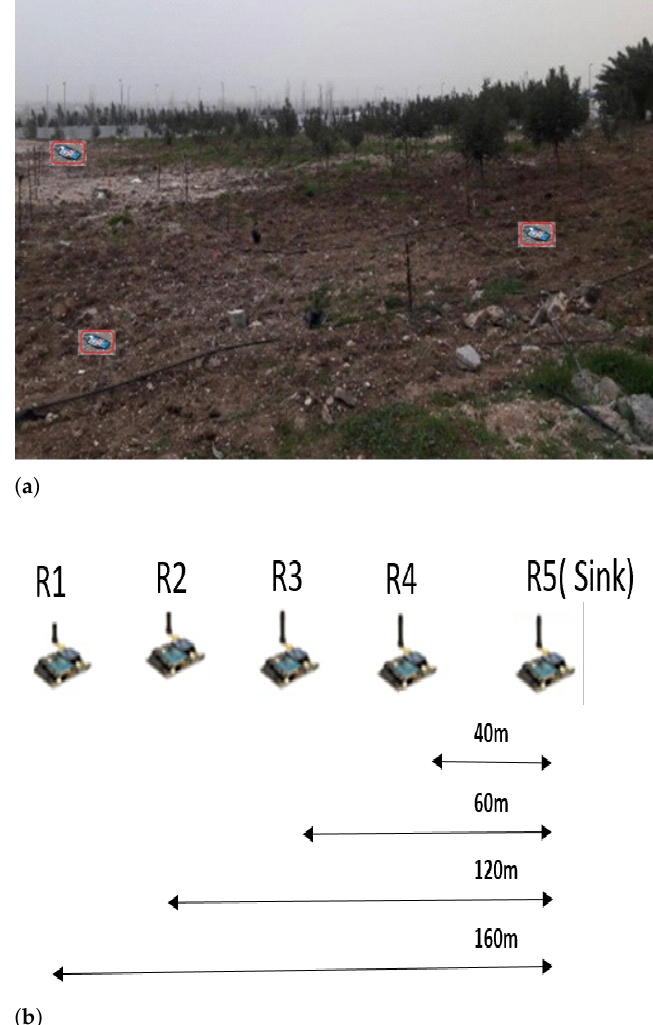
Figure 13. ( a ) wireless sensor nodes spread over line of sight area with small obstacles, ( b ) nodes’ alignments for different distance